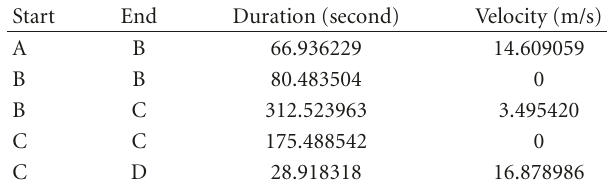
Table 4: Parameters of user motion in